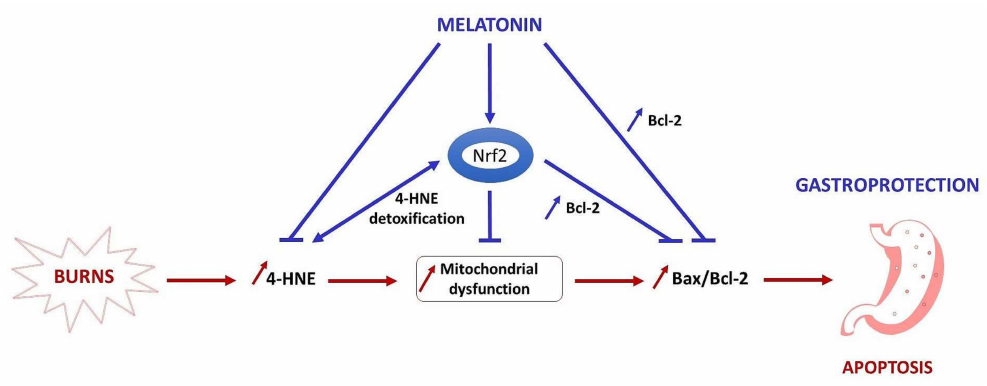
Figure 6. A schematic representation of molecular mechanisms and effects of melatonin in burn trauma. The experimental evidence indicates that exogenous melatonin exhibits a gastroprotective